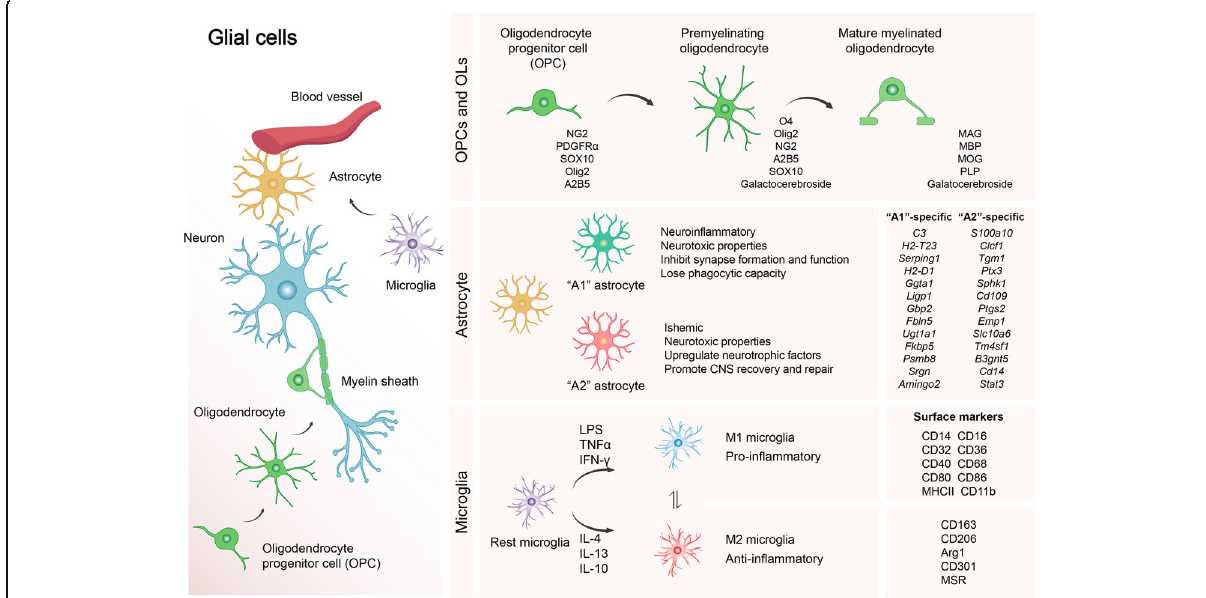
Fig. 1 Schematic representation of glial cells in the CNS, along with their classification and representative marker genes. Oligodendrocytes, astrocytes, and microglia are the major population of glial cells in CNS. Oligodendrocytes (OLs) are myelinating cells derived from oligodendrocyte progenitor cells (OPCs). OLs and OPCs are important cellular components for remyelination, which is an important regenerative process to restore lost neurological function. OPCs express PDGFR α (platelet-derived growth factor receptor α ), the transcription factor SOX10, NG2, Olig2, and A2B5. After OPCs generate OLs, the cells start to express O4, galactocerebroside. Finally, mature myelinating OLs express myelin- associated glycoprotein (MAG), myelin basic protein (MBP), proteolipid protein (PLP), and myelin oligodendrocyte glycoprotein (MOG). Astrocytes are the most abundant cells in the mammalian CNS with the function of forming and maintaining blood-brain barrier (BBB), regulating regional blood flow, proving trophic, antioxidant and metabolic support to neurons, neurotransmitter recycling, immune signaling, and regulating neuronal synaptogenesis and synaptic transmission. Reactive astrocytes can be classified into two subtypes, termed as “ A1 ” (neurotoxic)/ “ A2 ” (neuroprotective) astrocytes, with the specific marker genes identified from the previous transcriptome analysis [49]. Microglia can be classified into two states: M1 (classic) or M2 (alternative), which are responsible for tissue injury and repair,